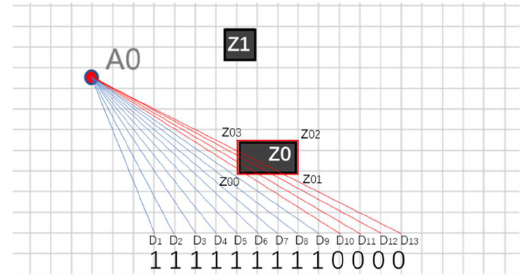
Figure 3. Determined schematic diagram of LOS/NLOS of anchor.